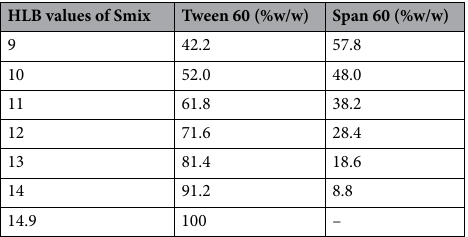
Table 1. Tested ratios of Smix constituents Tween 60 and Span 60 and corresponding